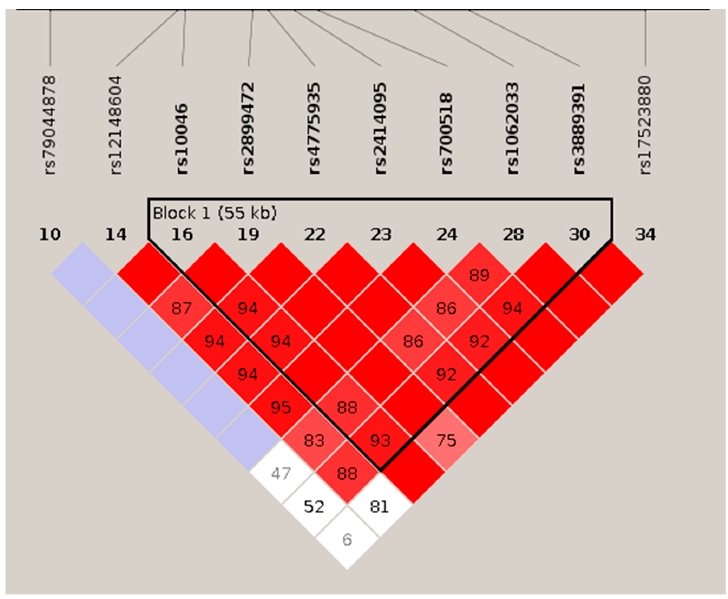
Figure 9. Linkage disequilibrium across the CYP19A1 gene. By using Gabriel’s method, a long 55 Kb haplotypic block with 7 SNPs is revealed. PDSS1 encodes the subunit 1 of Decaprenyl Diphosphate Synthase. This enzyme pro ‐ duces prenyl diphosphates of varying chain lengths and elongates the prenyl side chain of coenzyme Q, or ubiquinone, a component of the respiratory chain. We found an asso ‐ ciation of SERM ‐ induced changes in BMD with allelic variants of PDSS1, specifically with